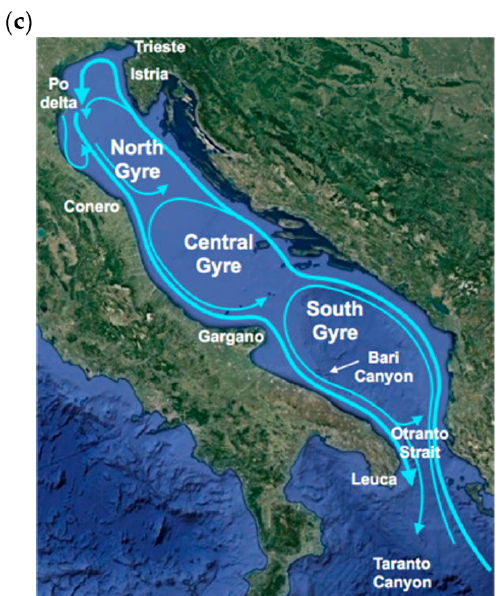
Figure 1. Mean flow fields and circulation cells in the Adriatic Sea obtained by numerical particles in this study during 2007 ( a ), 2008 ( b ), and the example of study area ( c ), for more details about the maps of study area see: [32]).